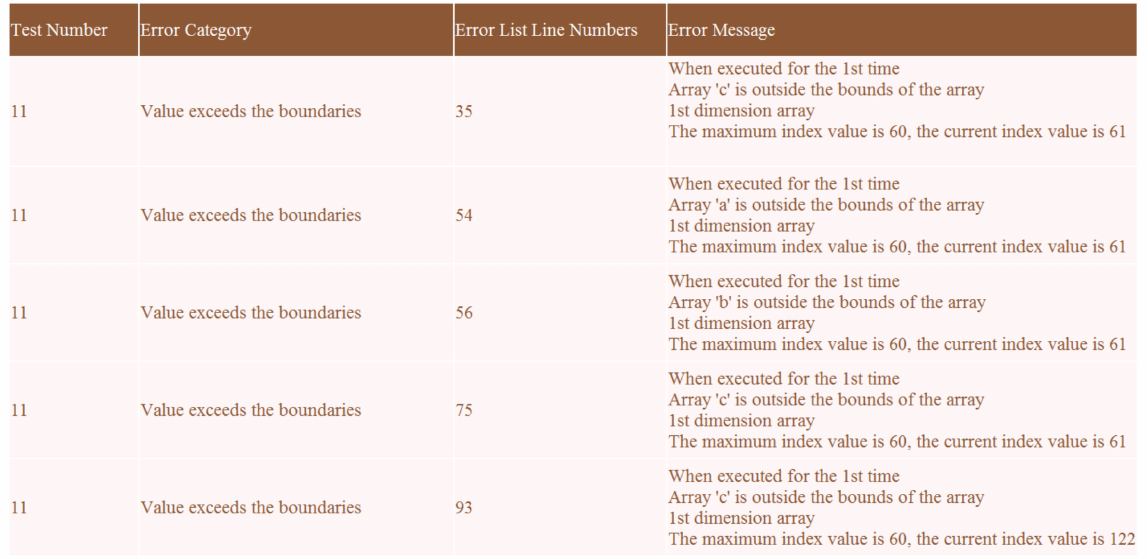
Figure 15. Feedback report